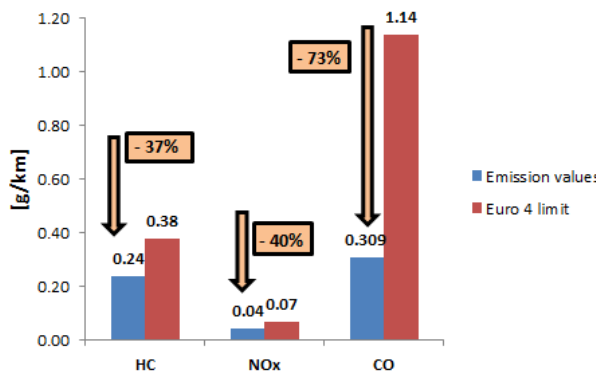
Fig. 11 Comparison of the determined road emission with the Euro 4 emission standard Using the determined mass emissions of individual gas compounds and the distance traveled during the whole test, the road emission of each compound was calculated. The obtained emission values were compared with the admissi- ble values specified for the Euro 4 standard (Fig. 11). The set emission value limits were not exceeded. For CO, an emission value was 73% lower than the limit value, for HC and NO it was lower by almost 40%, which was associated x with high efficiency of the engine exhaust aftertreatment system, which comprised of a three-way catalytic reactor (allowing oxidation of carbon monoxide and hydrocarbons at simultaneous reduction of nitrogen oxides). Meeting the emission standards was also the result of the fact that the vehicle was still fairly